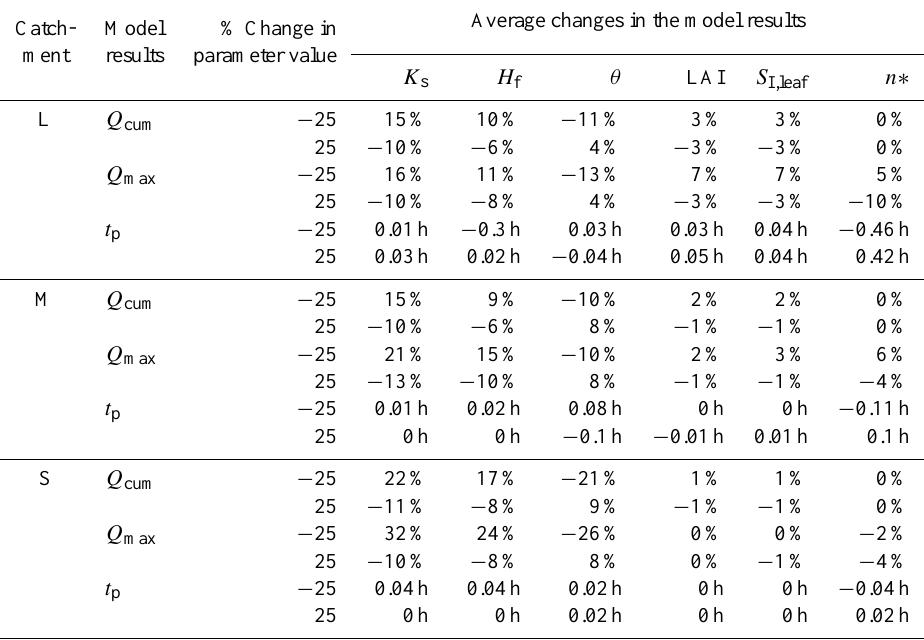
Table 7. Sensitivity of the model results with the closure relation C ∗ . Values are averaged over all events ( n = 13). Average changes in the model results Catch- Model % Change in ment results parameter value K s H f θ LAI S I,leaf